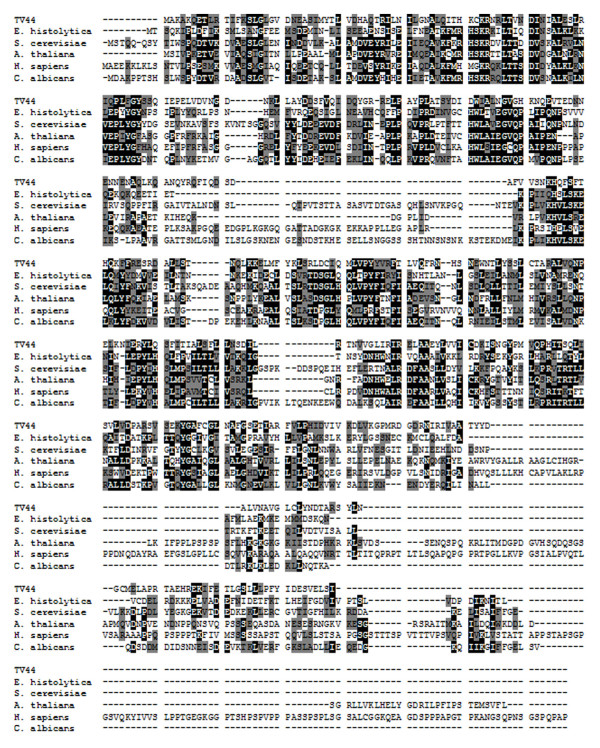
TV44 amino acid sequence alignment with proteins of BLAST search. The corresponding proteins of Entamoeba histolytica [XM 645307.1], Saccharomyces cerevisiae [P 53040], Arabidopsis thaliana [AY463621.1], Homo sapiens [AAH18115], and Candida albicans [XM 711022.1] were aligned by the Clustal W program. The conserved residues are indicated by black shading, and similarity is indicated by grey shading. TV44 had partial homology to transcription initiation factor (TFIID) of E. histolytica (13% identity) and S. cerevisiae (16%). TV44 had homology to the TATA-binding protein associated factor of A. thaliana (15%) and H. sapiens (13%) and, in addition, to the RNA pol II transcription factor of C. albicans (17%).